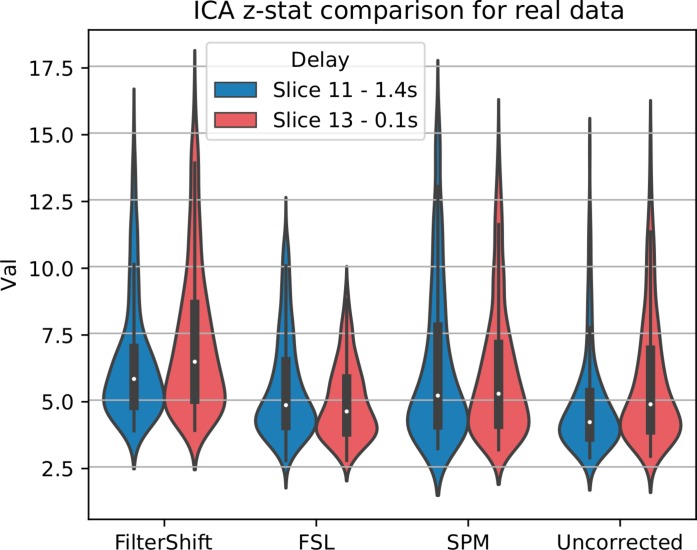
STC on the ability to extract functionally connected regions in real data. For each real subject, a task IC was extracted with MELODIC, and the IC’s time series was regressed onto the subject’s data using FSL’s dual regression. Z statistics from a low and high delay slice were extracted for low motion subjects and plotted here. For uncorrected data, the extracted IC performs as well as STC data in the low delay slice, but poorly explains the variance in the high delay slice, resulting in a lower z-statistic. For STC data, the average z-statistics are comparable for both high and low delay slices.